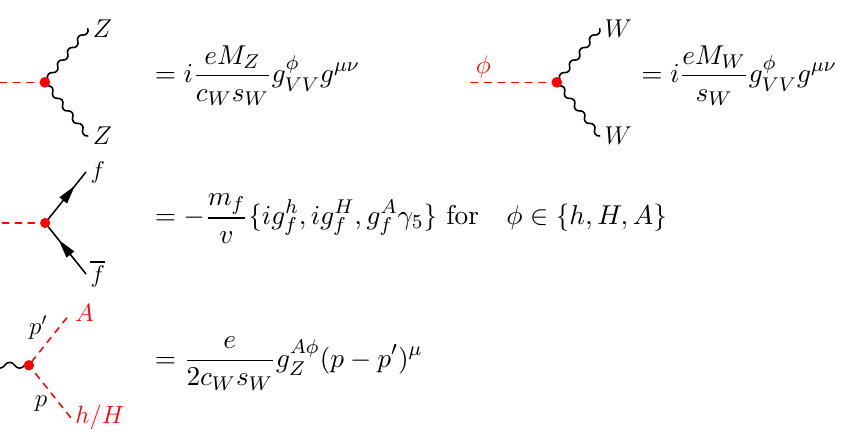
Figure 5 . Feynman rules for the Higgs couplings in the 2HDM . All momenta are